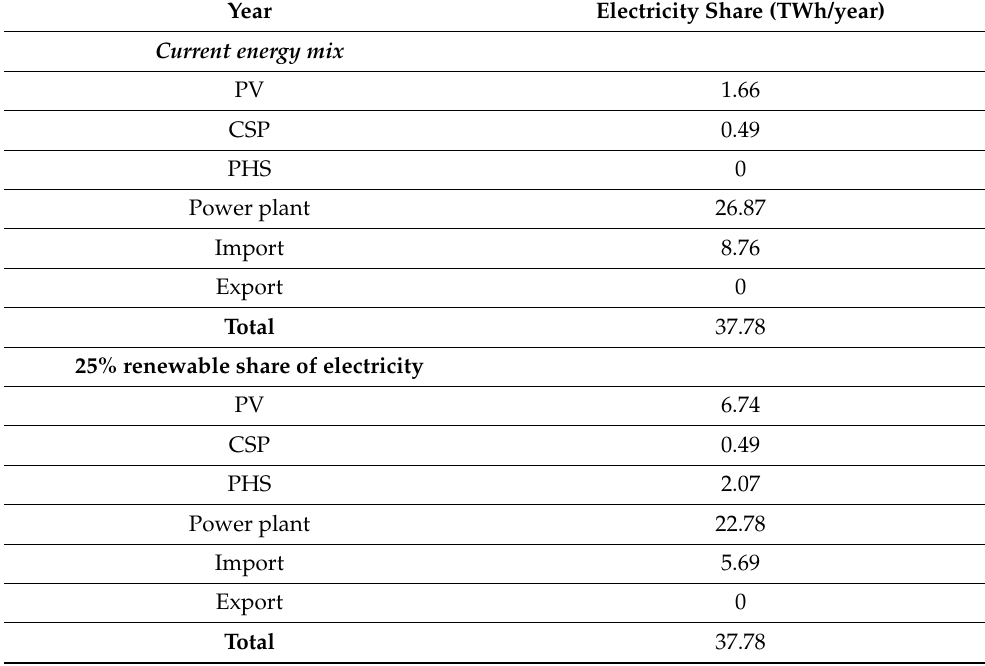
Table 14. Total annual electricity production required for the achievement of the 2030 goal of utiliz- ing renewable energy sources to supply 25% of the electricity in the UAE.